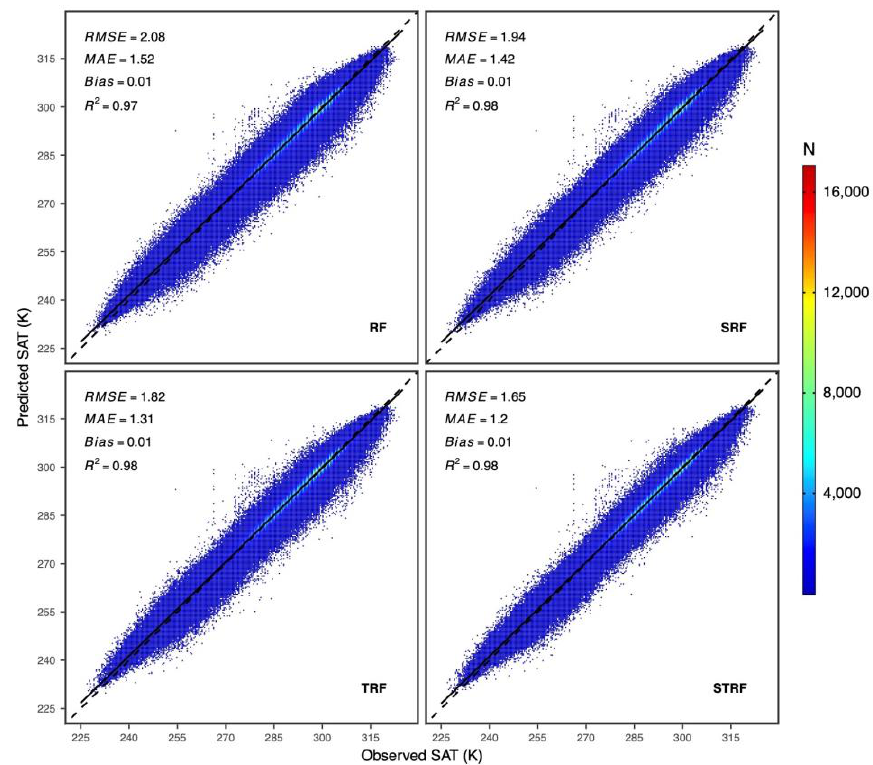
Figure 2. Overall agreement between observed SAT and predicted SAT using sample-based cross-validation for the four hourly SAT estimation models (RF, SRF, TRF, STRF).